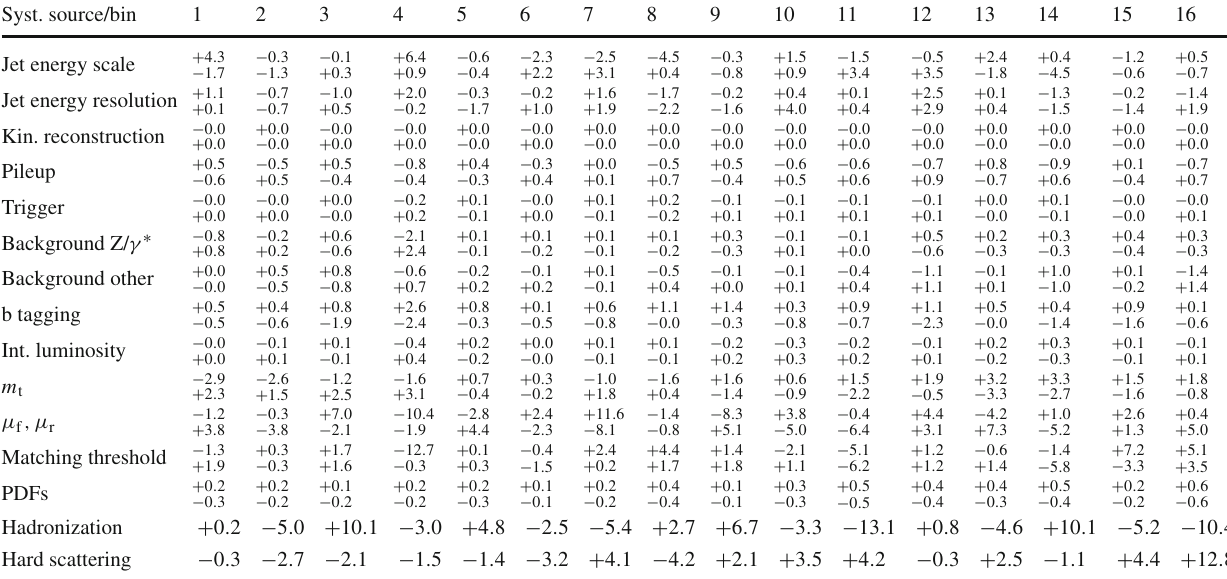
Table 19 Sources and values of the relative systematic uncertainties in percent of the measured normalized tt double-differential cross sections as a function of M ( tt ) and p T ( tt ) . For bin indices see Table 17 Syst. source/bin